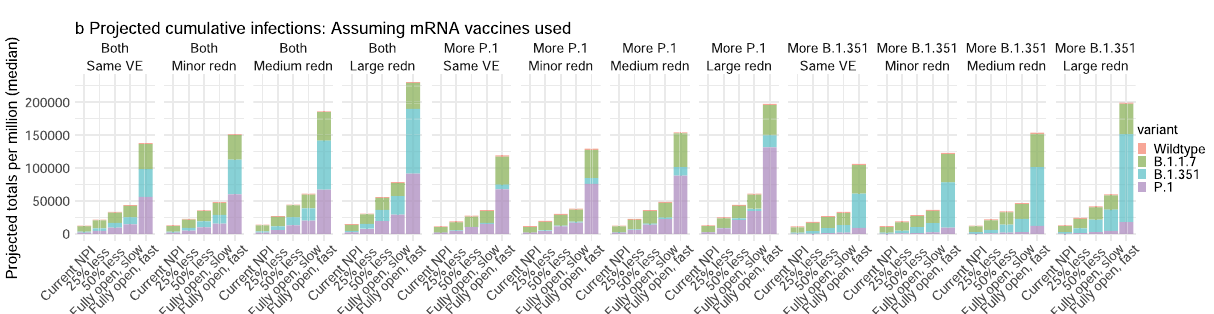
Fig. 4 Model projections of infection, under different scenarios of VOC co-circulation, NPIs, and reduction of vaccine ef fi cacy (VE) against the VOCs. a Example projected epidemic trajectories for each variant assuming mRNA vaccines are used and the VE is as high as for the wild-type virus. Lines and surrounding areas show model-projected median and interquartile range, from n = 1000 simulations (color-coded for each variant as indicated by the legend). b Tallies over the entire simulation period (May – Aug 2021) for different scenarios of seeding, change in VE (as indicated in the subtitles, see detail in Supplementary Table 5), and NPIs (as indicated by the x axis labels, see detail in Supplementary Table 5). All numbers are scaled to per 1 million people. For the projected percentages for each variant and uncertainty bounds, see Supplementary Table